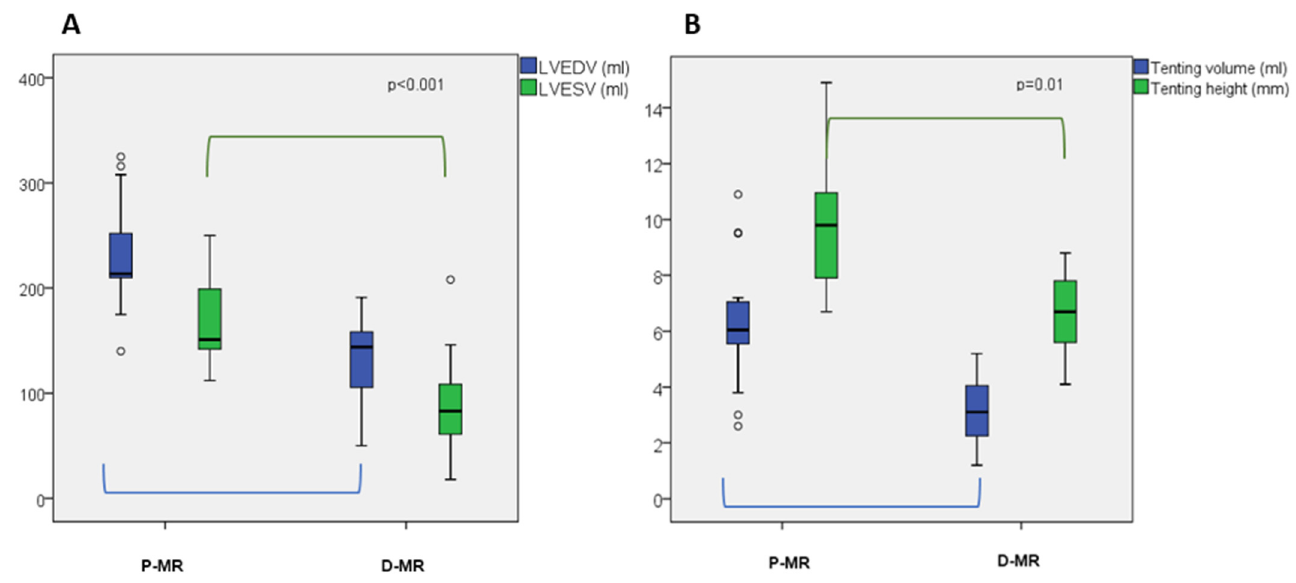
Figure 3. ( A ) Differences in mean LVEDV and LVESV between D-MR and P-MR patients, where p < 0.001 in both cases. ( B ) Differences in mean tenting height and tenting volume between D-MR and P-MR patients, where p = 0.01 in both cases. Box plots represent median, quartiles and extremes, and while circles represent the outliers.